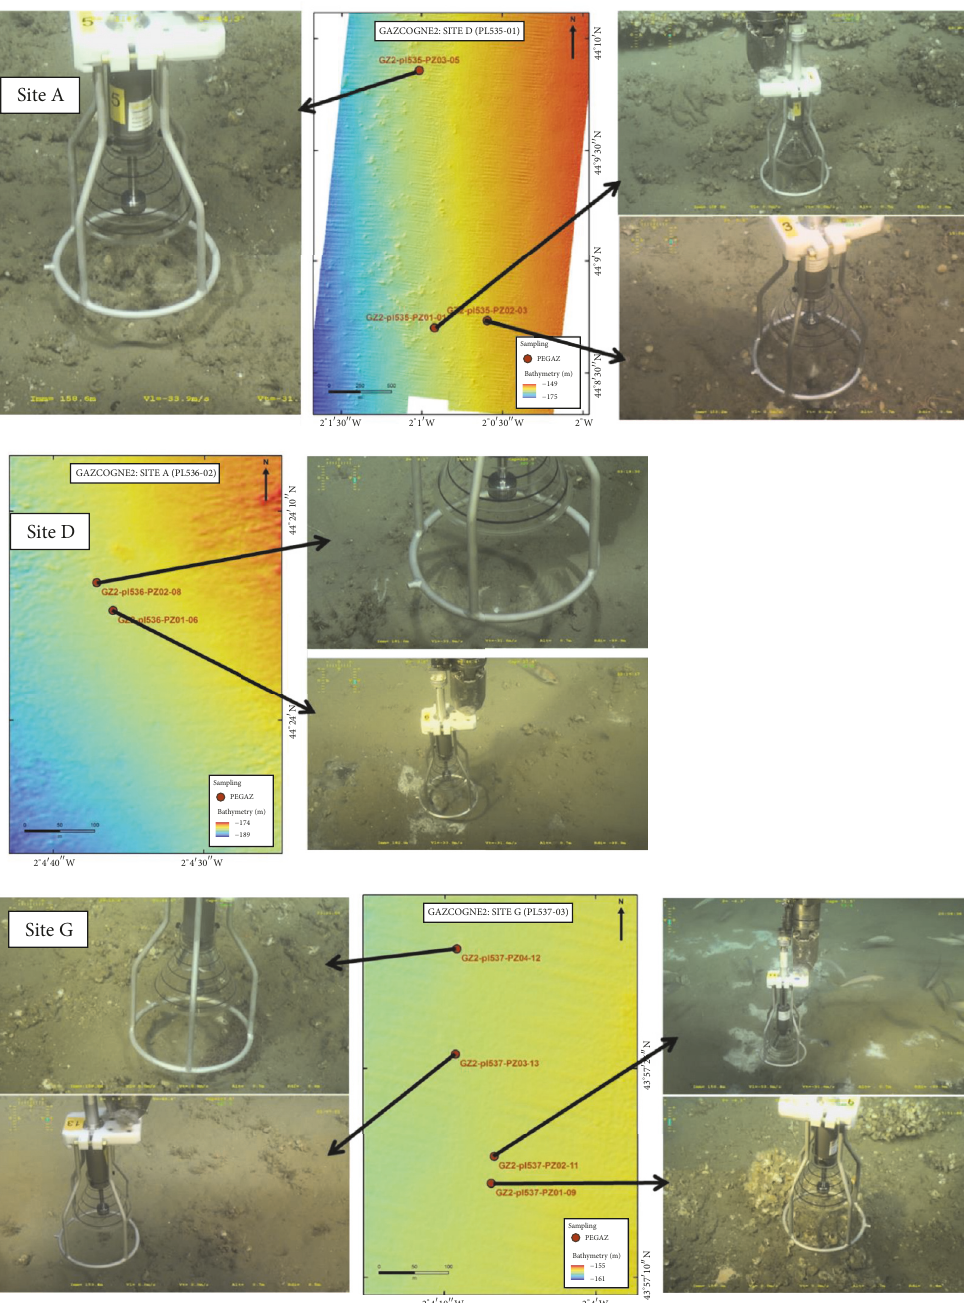
Figure 2: Dives on sites D, A, and G with the corresponding sampled